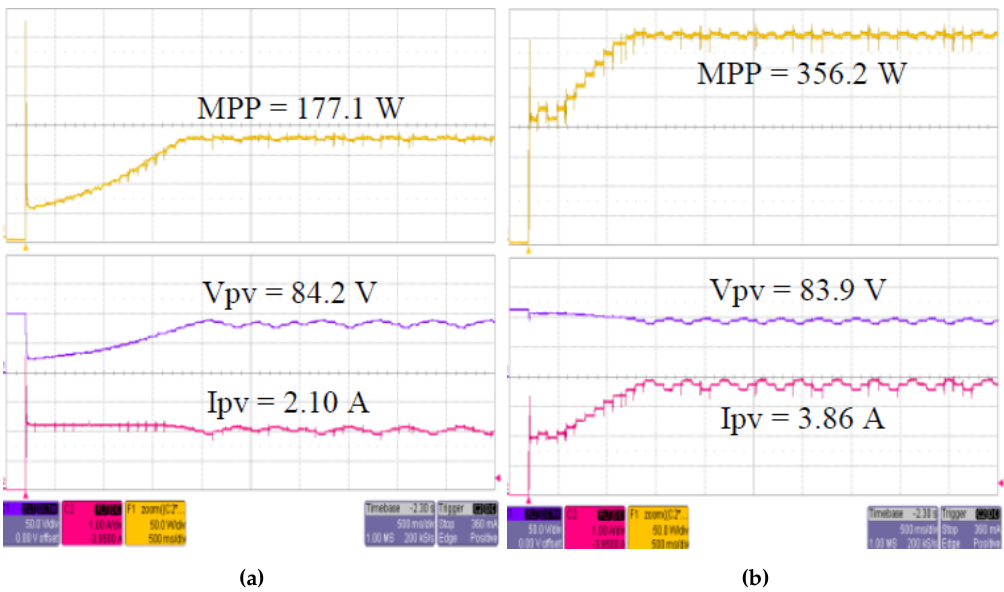
Figure 9. Tracking result of: ( a ) 334 W/m 2 setting; and ( b ) 667 W/m 2 setting.